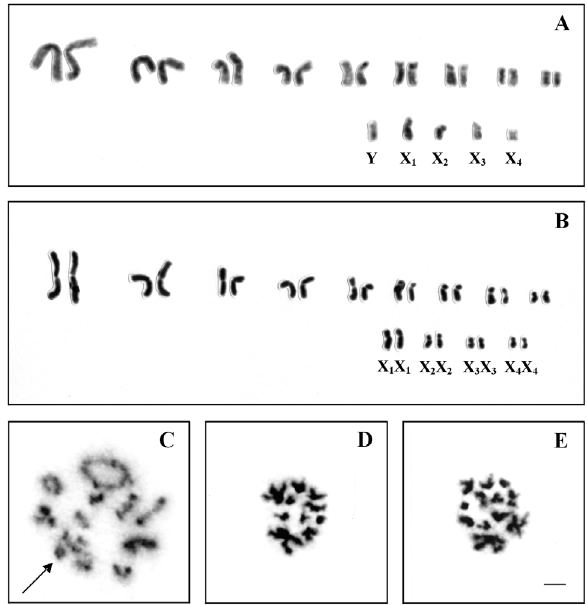
Figure 3 - Mitotic and meiotic chromosomes of Cicindela suturalis . (A) Malekaryogram,2n=18+X 1 X 2 X 3 X 4 Y;(B)Femalekaryogram,2n=18+ X 1 X 1 X 2 X 2 X 3 X 3 X 4 X 4 ; (C) male metaphase I; (D) male metaphase II, n = 9 + Y and (E) male metaphase II, n = 9 + X 1 X 2 X 3 X 4 . Arrow indicates the multiple sex chromosomes. Bar = 4 µ